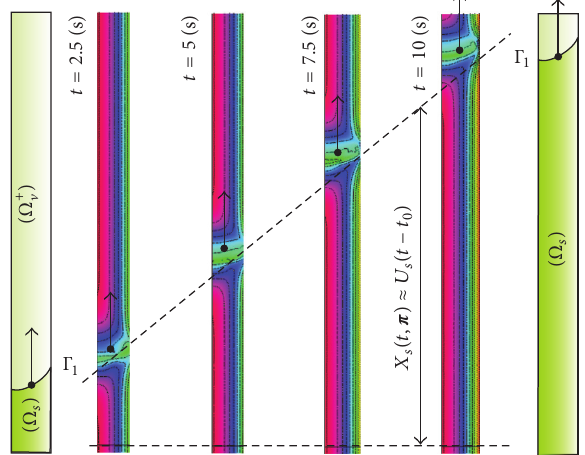
Figure 16: Illustration of the flow contours at the sequence of times ) = (5𝑘/2) (𝑡 𝑘 𝑘∈[1,5] 𝑘∈[0,4] [s].